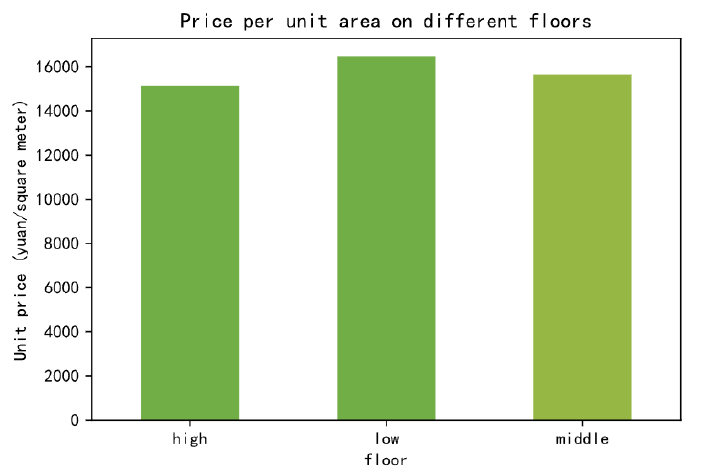
Fig. 5 Price per unit area of various